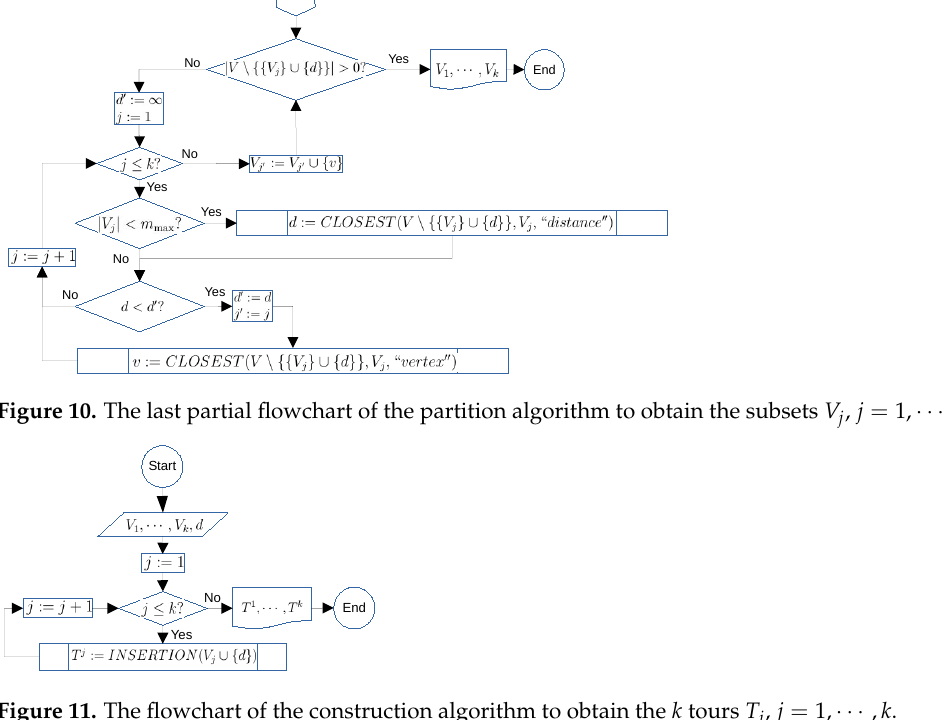
Figure 11. The flowchart of the construction algorithm to obtain the k tours T j , j = 1, · · · , k